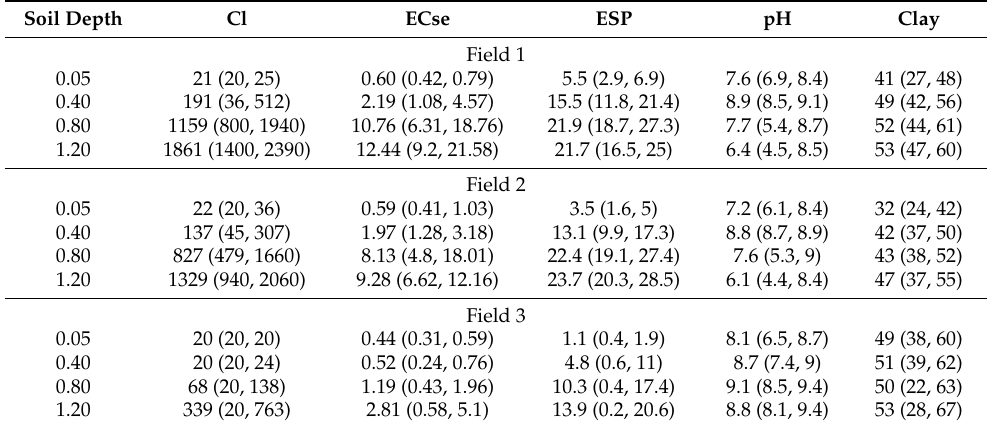
Table 1. Mean values (min, max) of soil properties for each of the five fields in the study area. Soil